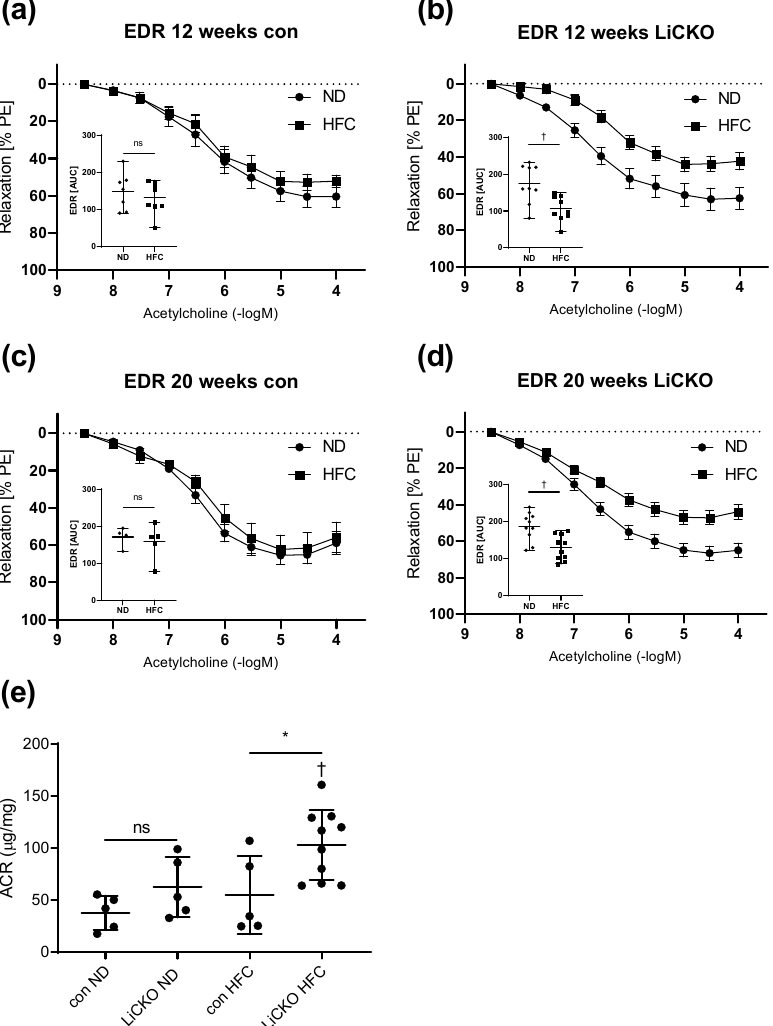
Figure 7. Effect of diet and genotype on vascular and endothelial function. ( a , c ) No effects of HFC diet on EDR were observed in control mice at 12 or 20 weeks of diet. Inserts show AUC for EDR; ( b , d ) Impaired EDR in LiCKO mice at both 12 and 20 weeks of HFC diet. Inserts show AUC for EDR; Quantification of the AUC demonstrated decreased EDR in LiCKO mice at both 12 and 20 weeks of HFC diet; ( e ) Increased ACR in urine of LiCKO mice at 20 weeks of HFC indicated renal endothelial damage. * p < 0.05 difference between con and LiCKO on same diet; † p < 0.05 difference between ND and HFC for con or LiCKO; ns = non-significant.